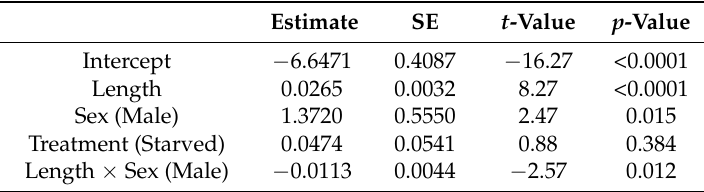
Table 2. Parameter estimates from the linear model of intestine dry mass, with statistical summary. SE = standard